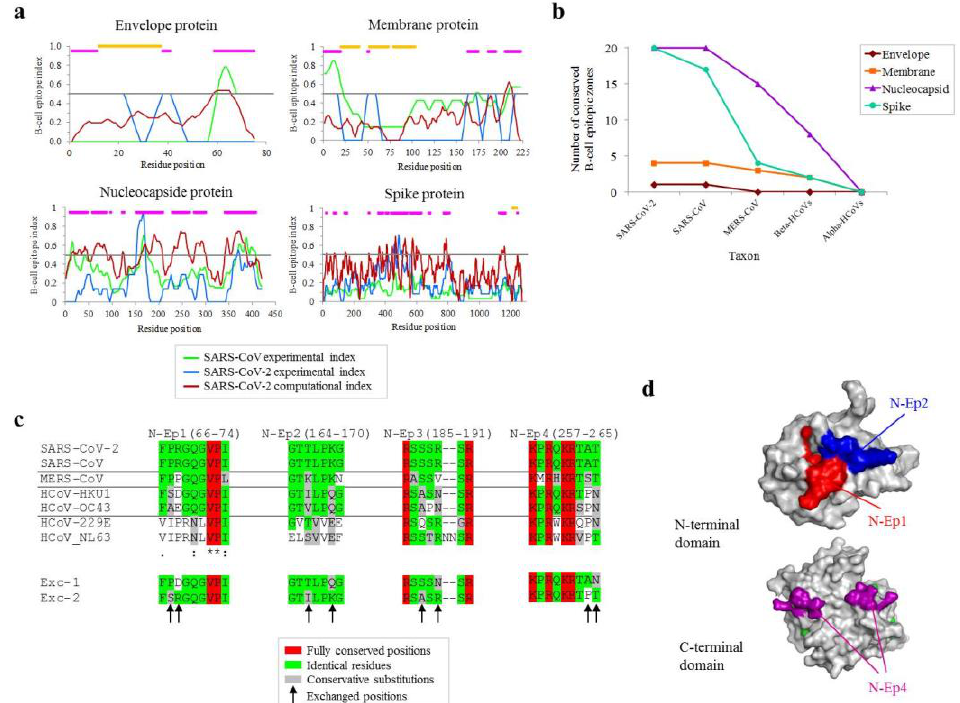
Figure 1. Conservation of B-cell epitope zones at different taxonomical ranges. ( a ) Consensus B-cell epitope in the four virion proteins after computational prediction (red line), and experimental validation in SARS-CoV and SARS-CoV-2 applying a window of seven residues. The line indicates the 0.5 threshold applied to select epitopes. Consensus epitopes are in fuchsia. Transmembrane sections are in orange. ( b ) Taxonomical stepwise conservation of virion betacoronavirus antigens: number of conserved positions globally in the whole alignment (up to 15mers, split into proportional sections if more) extends ≥ 7 positions over 65% similarity and three identical residues, without indels. ( c ) Alignments of wild-type sequences and proposed consensus peptide sequences for the four most conserved epitopes in the nucleocapside protein. The degree of conservation is color-ranked (see inset legend). Shuffled positions in exchanged epitopes (Exc-1 and Exc-2) are shown (arrow). ( d ) Structural mapping of conserved epitopes. N-t nucleotide-binding (above) and C-t dimerization (below) domains are shown.